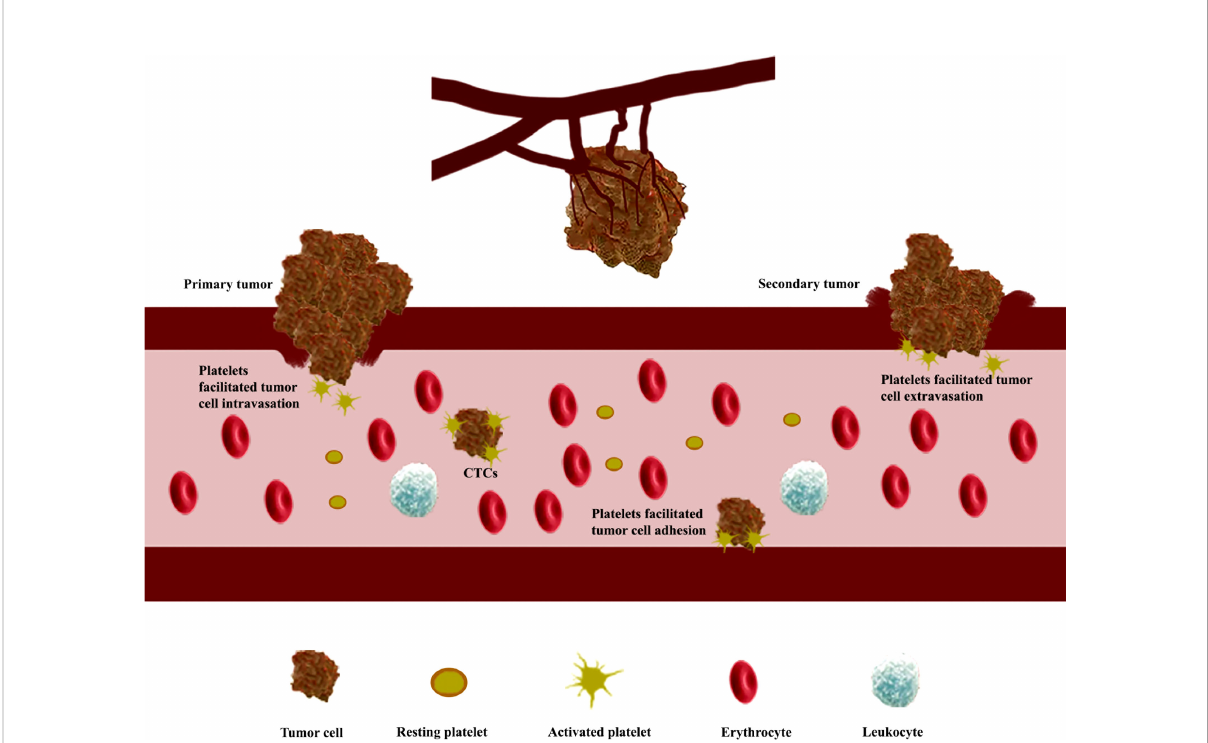
FIGURE 2 Platelets stimulate tumor angiogenesis, enhance vascular permeability, and promote the formation of metastatic tumors. Platelets stimulate tumor angiogenesis through the release of angiogenesis regulator factors, such as vascular endothelial growth factor (VEGF) and platelet-derived growth factor (PDGF), after activation in the tumor site; platelets trigger epithelial – mesenchymal transition (EMT) activation to enhance vascular permeability of tumor cell; circulating tumor cells (CTCs) binding with platelets are protected from shear stress and immune